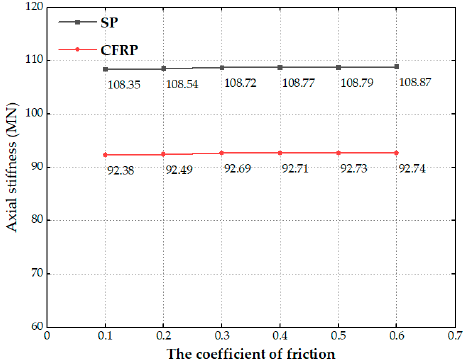
Figure 10. Axial tension response with different friction coefficients.